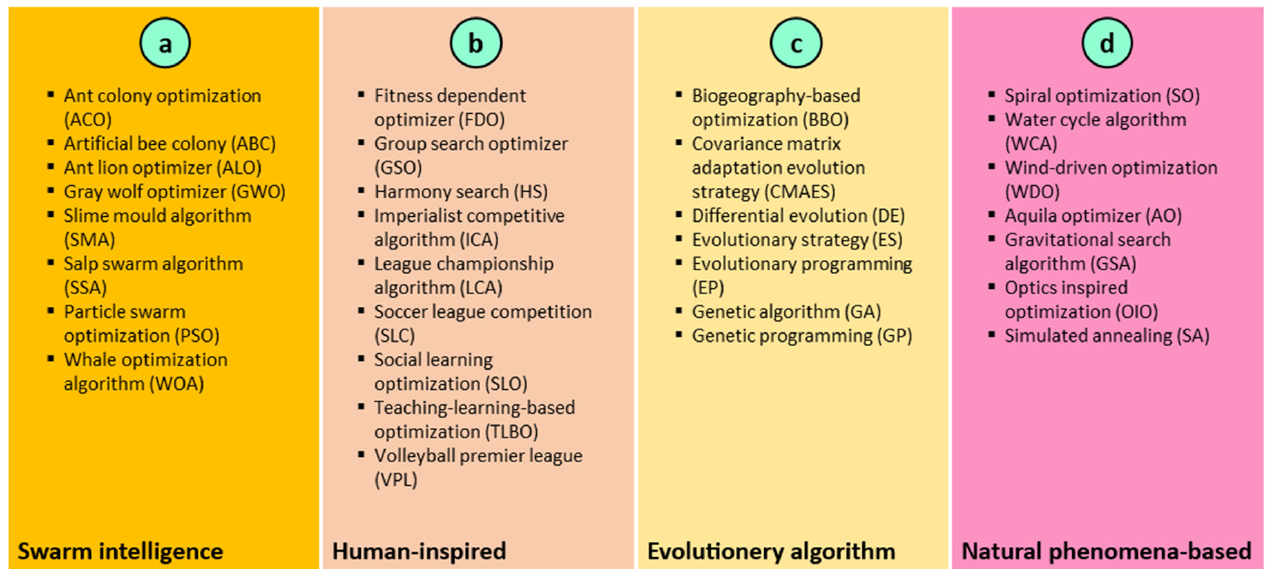
Figure 1. ( a – d ) Classification of MH algorithms.